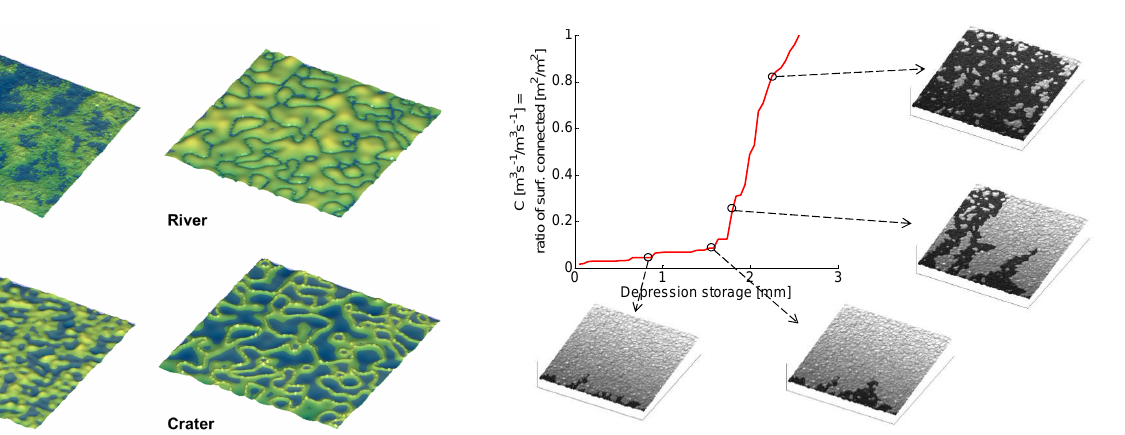
Figure 2: Example of Relative Surface Connection (RSC) function and connectivity evolution (areas connected to the bottom boundary are shown in black).